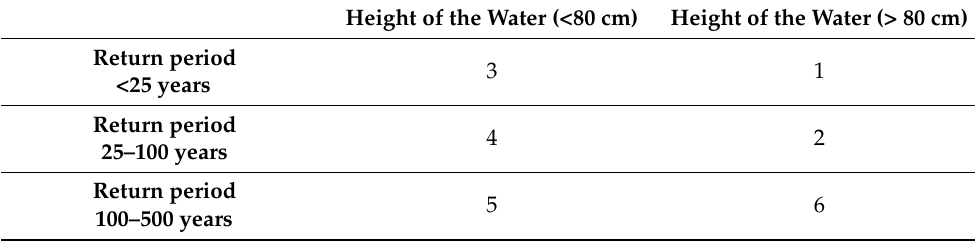
Table 3. Hazard levels of the PATRICOVA (from 1 to